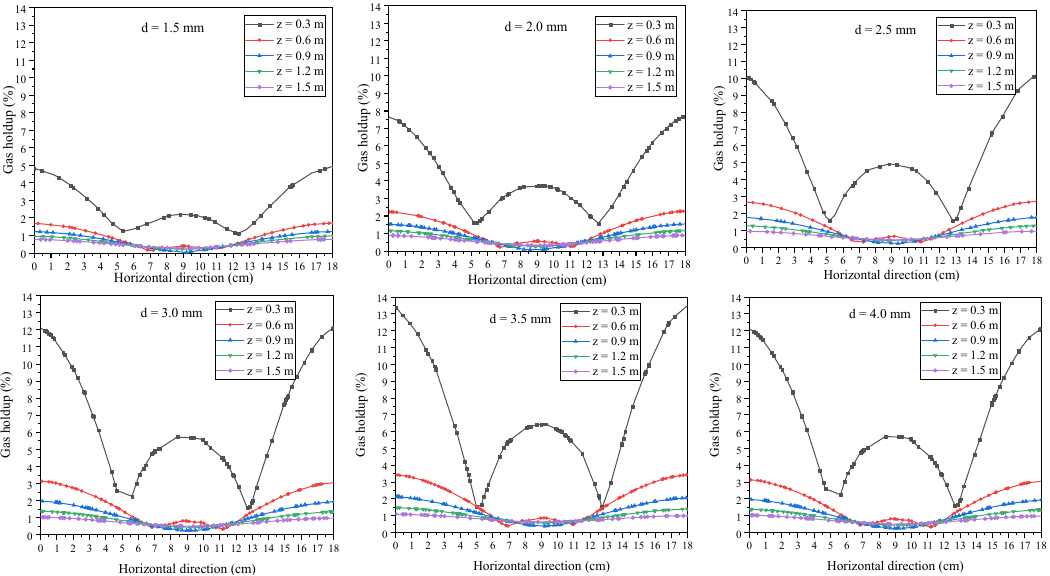
Figure 9. Gas holdup variation along the horizontal direction at different orifice diameters.